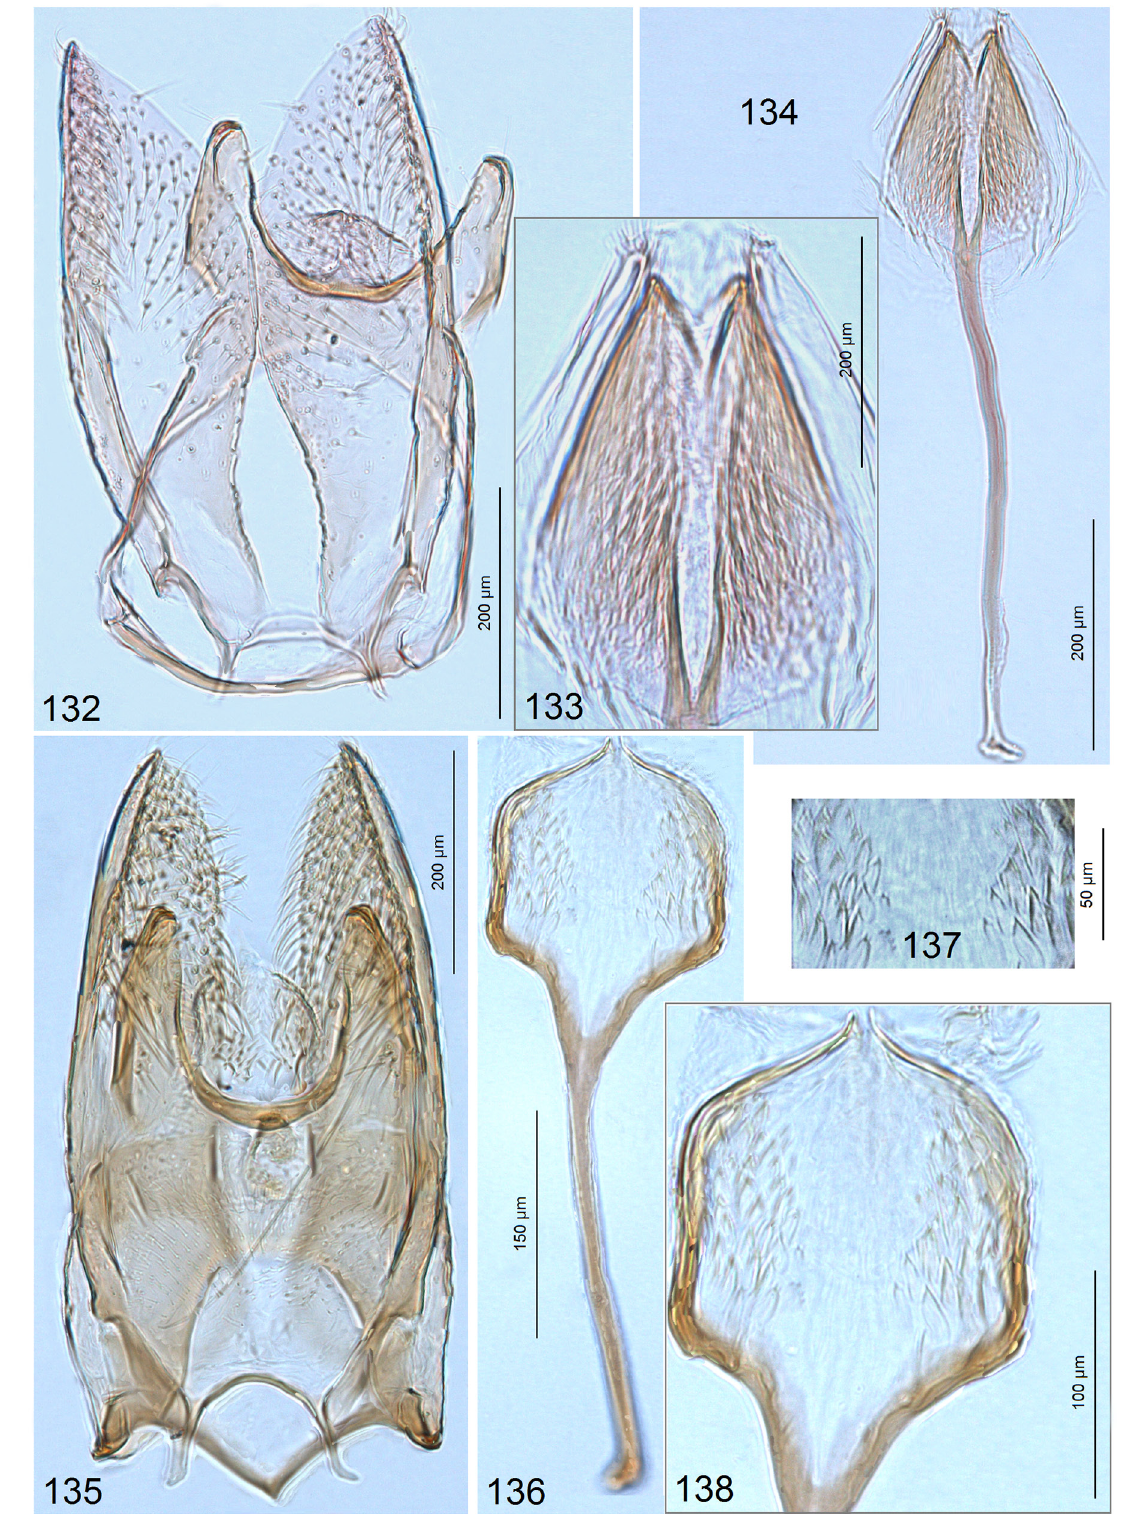
Figs 132–138. Male genitalia of Tischeriidae from Las Cuevas, Belize (NHMUK). 132 . Coptotriche pulverea (Walsingham, 1897), capsule with phallus removed (genitalia slide no. 010316203). 133–134 . Same, phallus. 135 . C. forsteroniae Stonis & Diškus, 2008, capsule with phallus